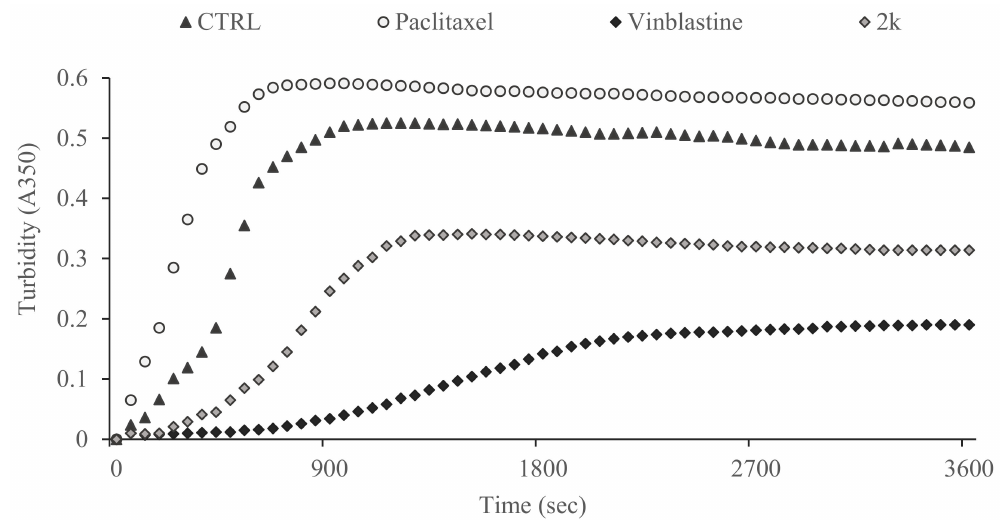
Figure 3. Tubulin polymerization assay. The in vitro tubulin polymerization was evaluated after tubulin incubation with compound 2k used at the concentration of 10 µ M. Vinblastine and paclitaxel (10 µ M) were used as positive controls, while vehicle (DMSO) was used as a negative control. Tubulin polymerization was measured by determining the turbidity at 350 nm for 3600 s at 37 ◦